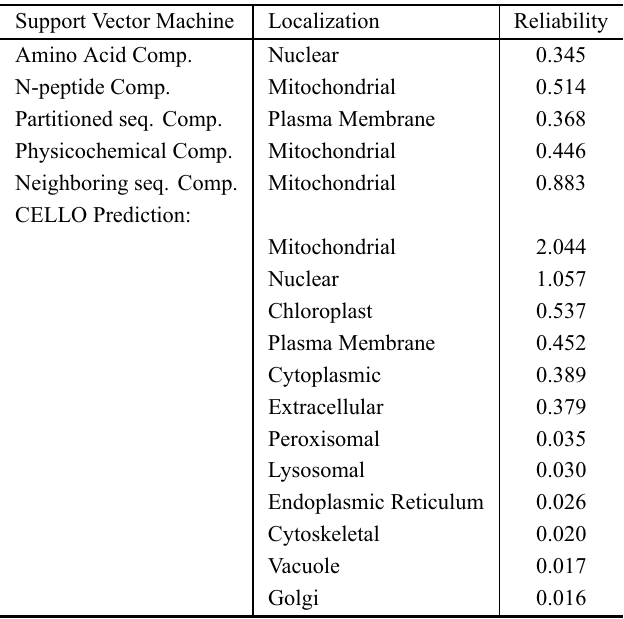
Protein subcellular localization for Der f 2 by CELLO